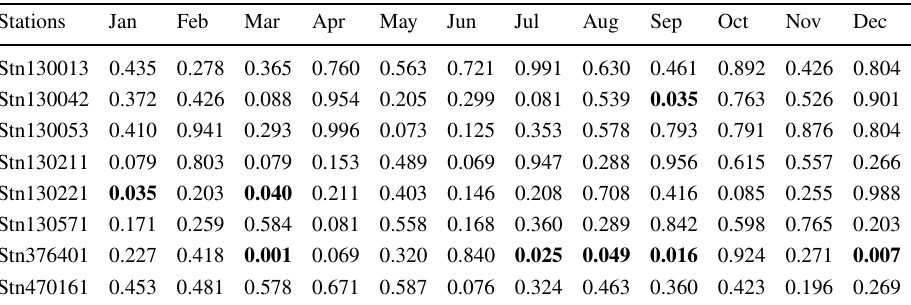
Bold number represents p < 0.05 indicating inhomogeneity in the corresponding time series at a 5% signifi-